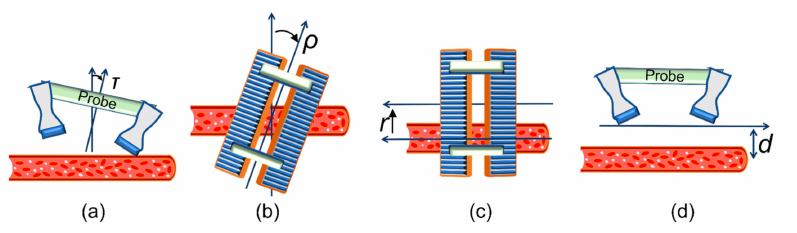
Figure 4. Probe positions tested in in vitro experiments: ( a ): tilt with − 15 ◦ ≤ τ ≤ +15 ◦ ; ( b ): rotation with 0 ≤ ρ ≤ 20 ◦ , ( c ): lateral translations with random r values; ( d ): depth with 19 ≤ d ≤ 30 mm.